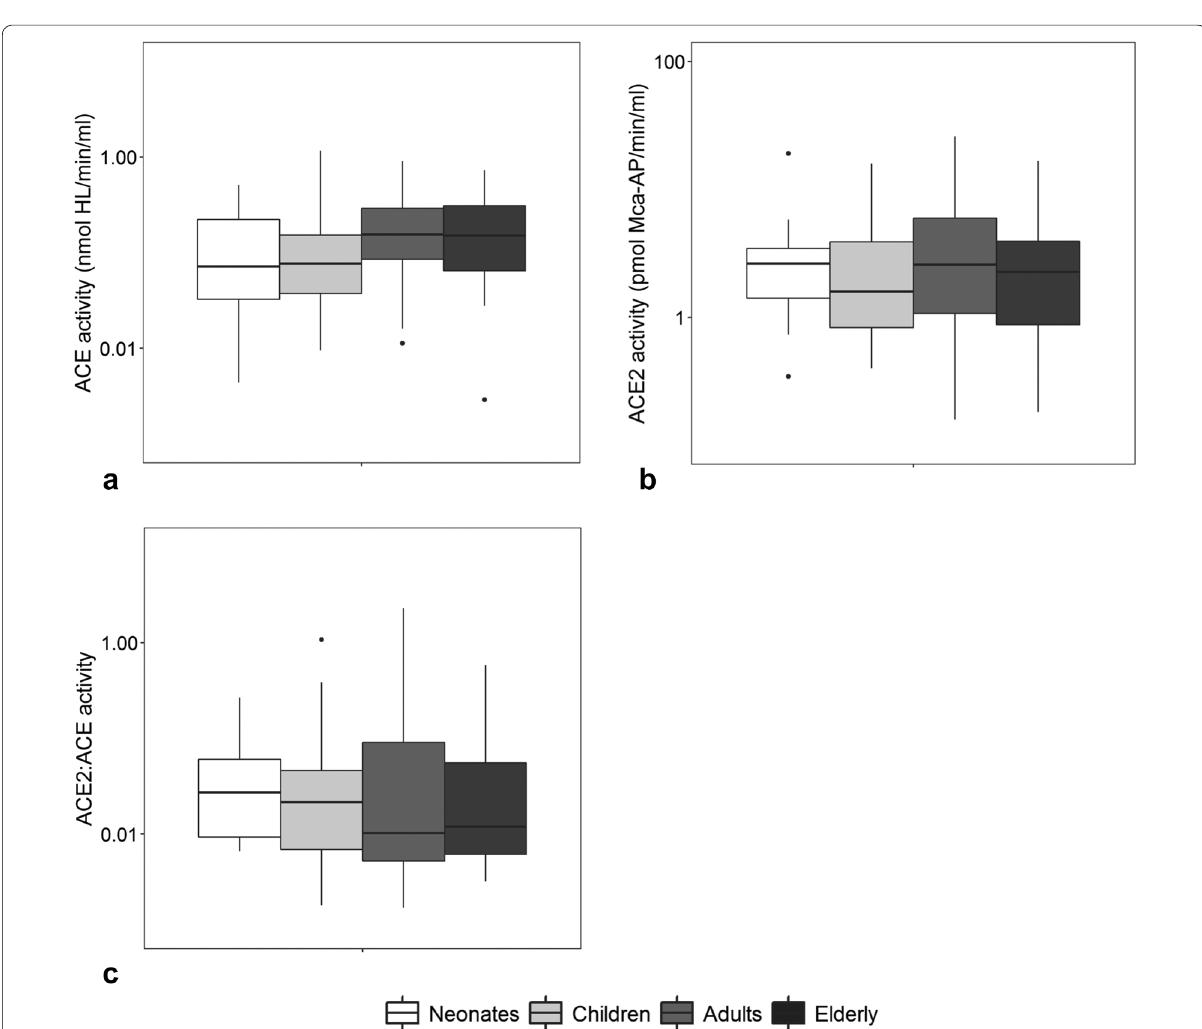
Fig. 3 ACE and ACE2 activity in bronchoalveolar lavage fluid of ARDS patients. a ACE and b ACE2 activity in bronchoalveolar lavage (BAL) fluid of ARDS patients stratified by four age groups. c ACE2/ACE ratio. Horizontal bars represent the median. Group differences were tested with a Dunn’s test with Bonferroni correction for multiple comparisons. A p value less than 0.05 was considered statistical significant. ACE angiotensin converting